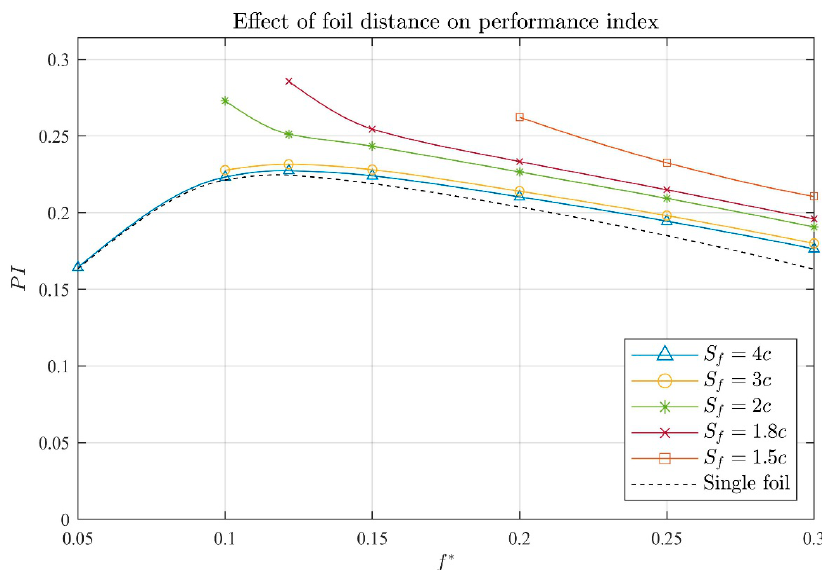
Figure 15. Performance of the twin-foil system for S f = { 1.5,1.8,2,3,4 } · c , θ 0 = 50 o and a / c = 0.5. The oscillation parameters are b / πρ csV bg = 1.12, k / s =